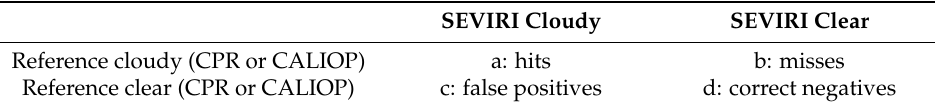
Table 1. Contingency matrix for comparison of Spinning Enhanced Visible and Infrared Imager (SEVIRI) cloud occurrence frequency (COF) with the cloud products from A-Train. SEVIRI Cloudy SEVIRI Clear Reference cloudy (CPR or